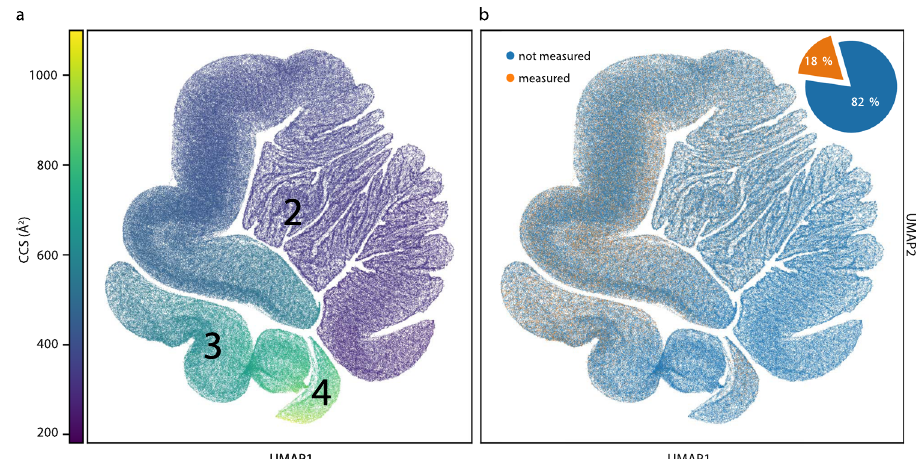
Fig. 6 The human peptide CCS universe. a Two-dimensional UMAP representation of 616,948 unique tryptic peptide sequences colored by their predicted CCS value. b Same UMAP plot. Peptide sequences with experimental values in this study are highlighted in orange